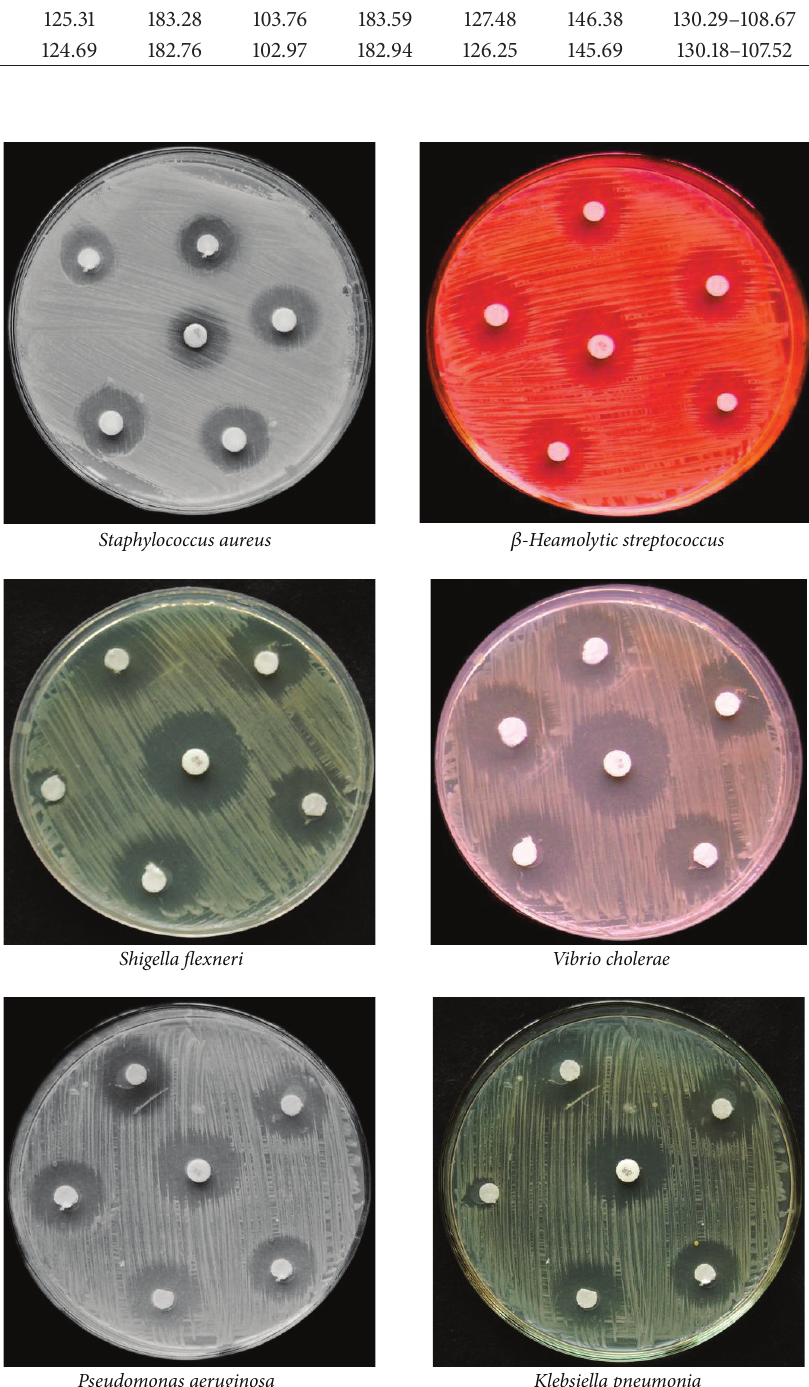
Figure 4: Representative photographs of disc diffusion method for compounds 1 – 5